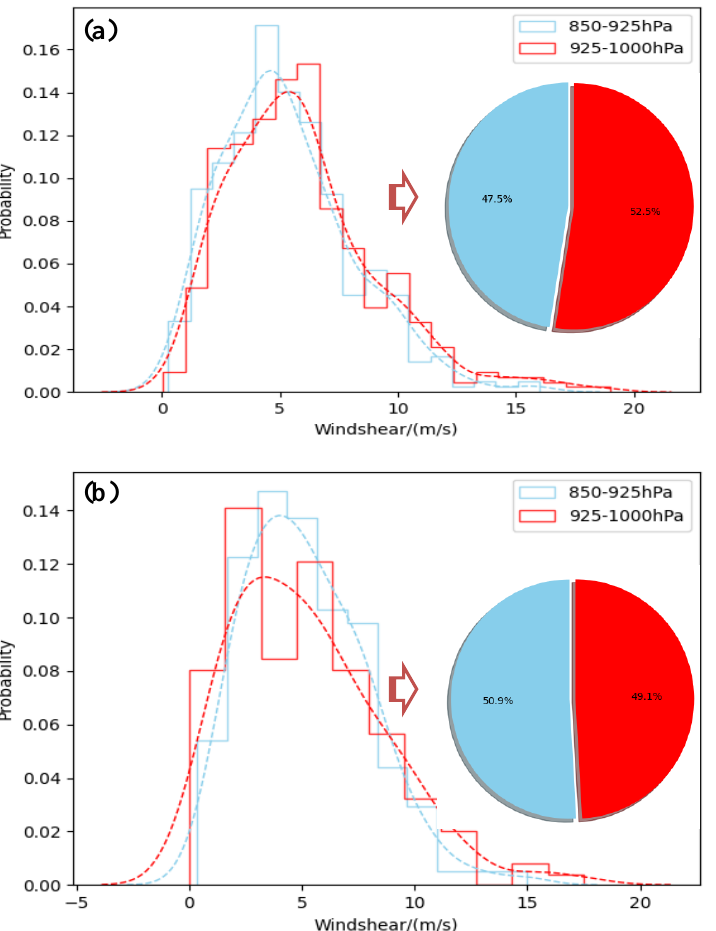
Figure 10. Distribution of the observed wind shears during the clean days ( a ) and polluted days ( b ), where the dashed line represents the probability distribution line during the clean days (red) and polluted days (blue).